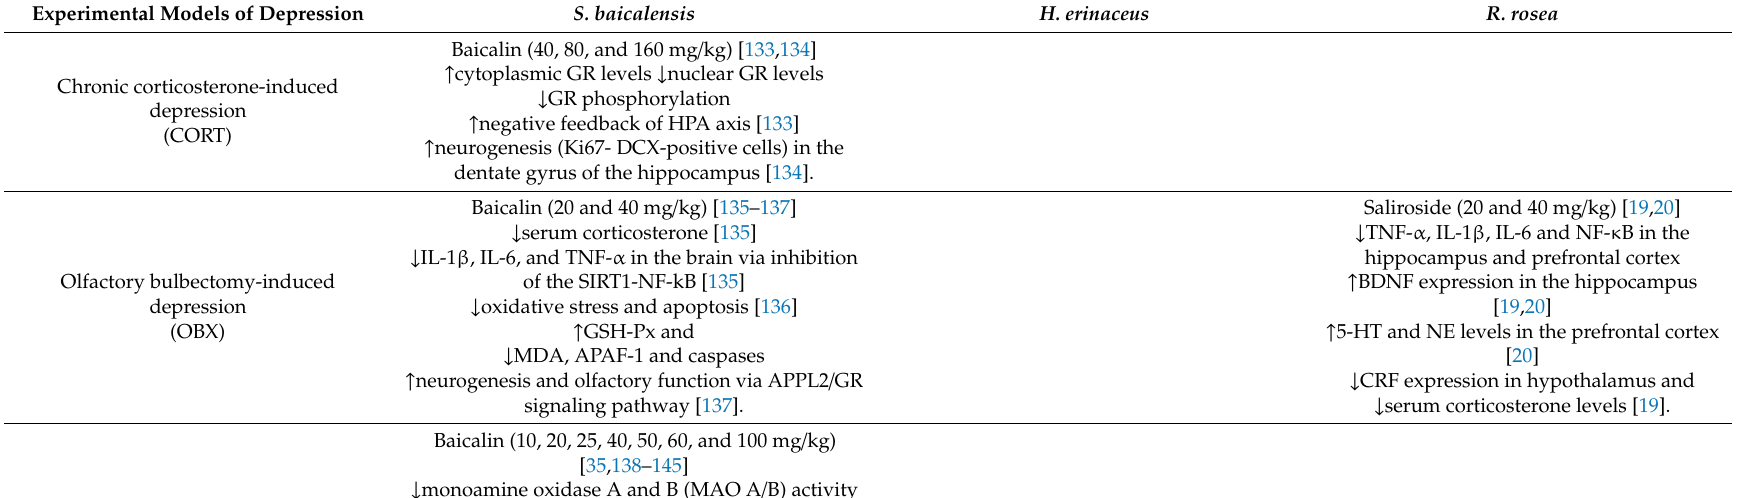
Table 1. Experimental and clinical studies centered on the antidepressant-like mechanisms and potential of S. baicalensis , H. erinaceus and R. rosea . Experimental Models of